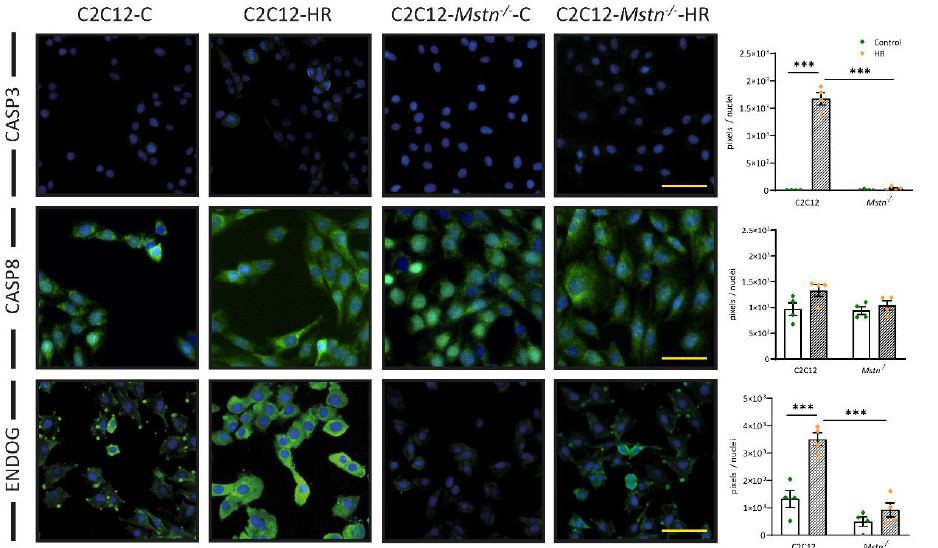
Figure 3. Expression levels of key proteins in intrinsic and extrinsic activation of apoptosis. Immunofluorescence analysis of intrinsic activation (caspase 3 and endonuclease G) and extrinsic activation (caspase 8), accompanied by representative images. C, control cells incubated under normoxia. HR, cells incubated under hypoxic conditions for 4 h followed by normoxia for 15 min. Cell nuclei were counterstained with DAPI. For each graph, four independent experiments per group were conducted. Scale bar = 50 μm. Results are shown as means ± SEM. CASP3, caspase 3; CASP8, caspase 8; ENDOG, endonuclease G. p -value: *** < 0.001; ANOVA followed by a multiple test comparison via Tukey’s post-hoc test (homoscedasticity) or Brown–Forsythe and Welch ANOVA followed by Dunnett’s T3 post-hoc test